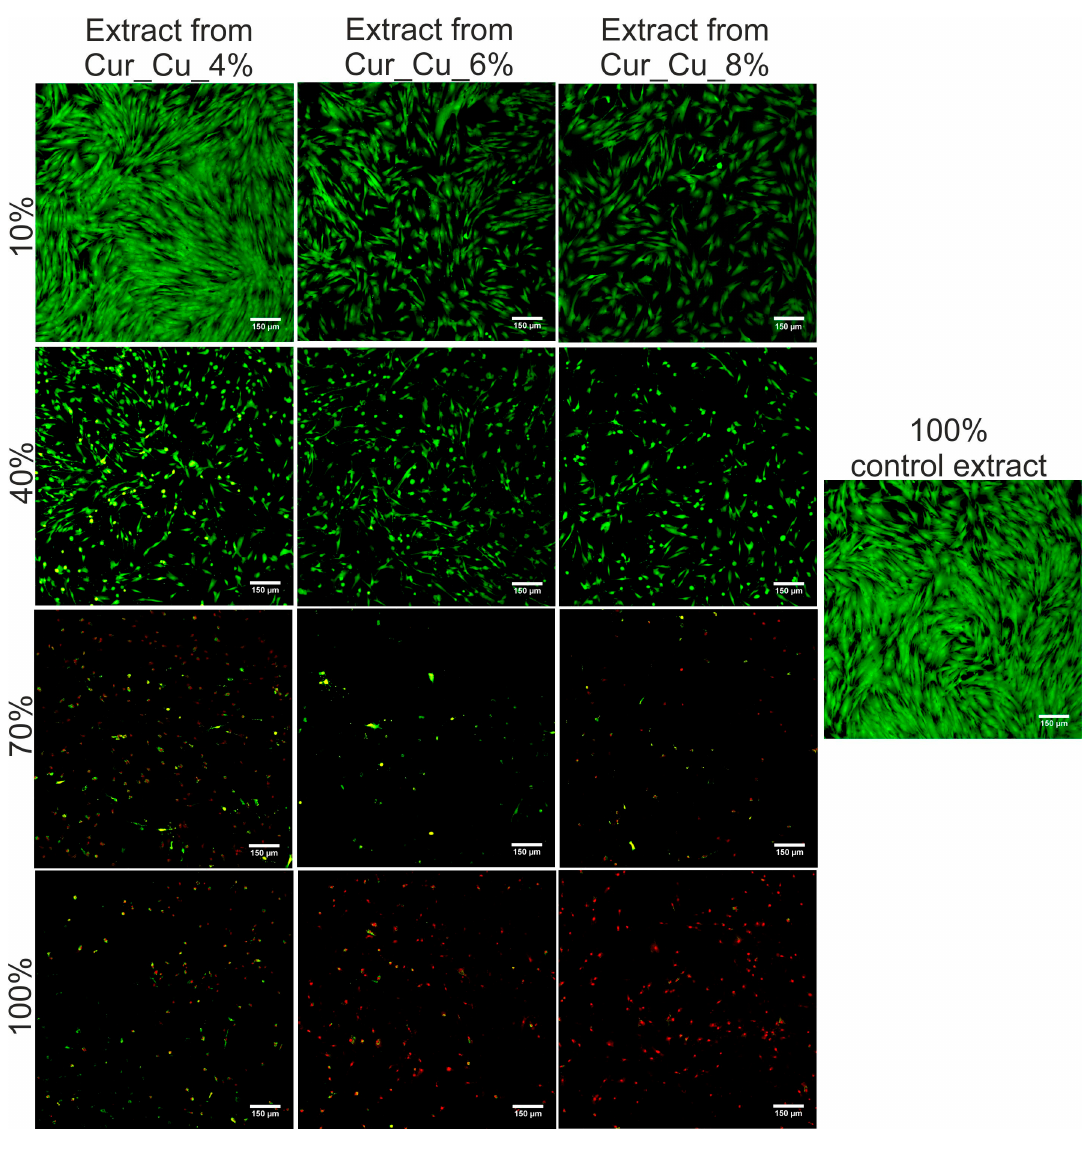
Figure 9. Representative images showing live (green fluorescence) and dead (red fluorescence) BJ cells after 24-h incubation with different concentration of extracts from Cur_Cu_4%, Cur_Cu_6%, and Cur_Cu_8% biomaterials. Pure culture medium incubated without biomaterials was served as control extract. Magnification 100×, scale bar equals 150 μ m.